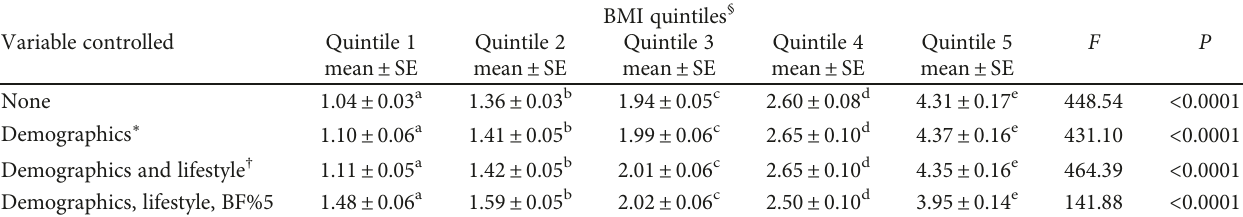
Table 4: Mean HOMA-IR values across BMI sex-speci fi c quintiles, without and with control of the covariates. Variable controlled